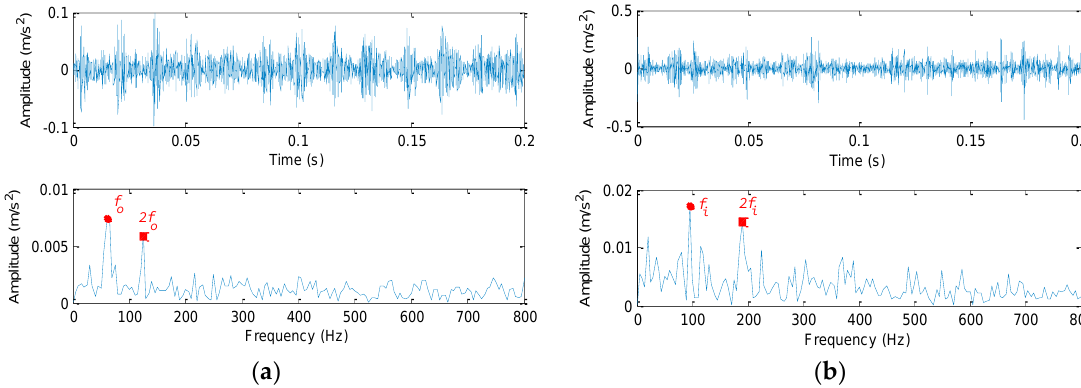
Figure 14. Waveform of reconstructed bearing vibraion signal and its envelope spectrum: ( a ) ORF and ( b ) IRF.